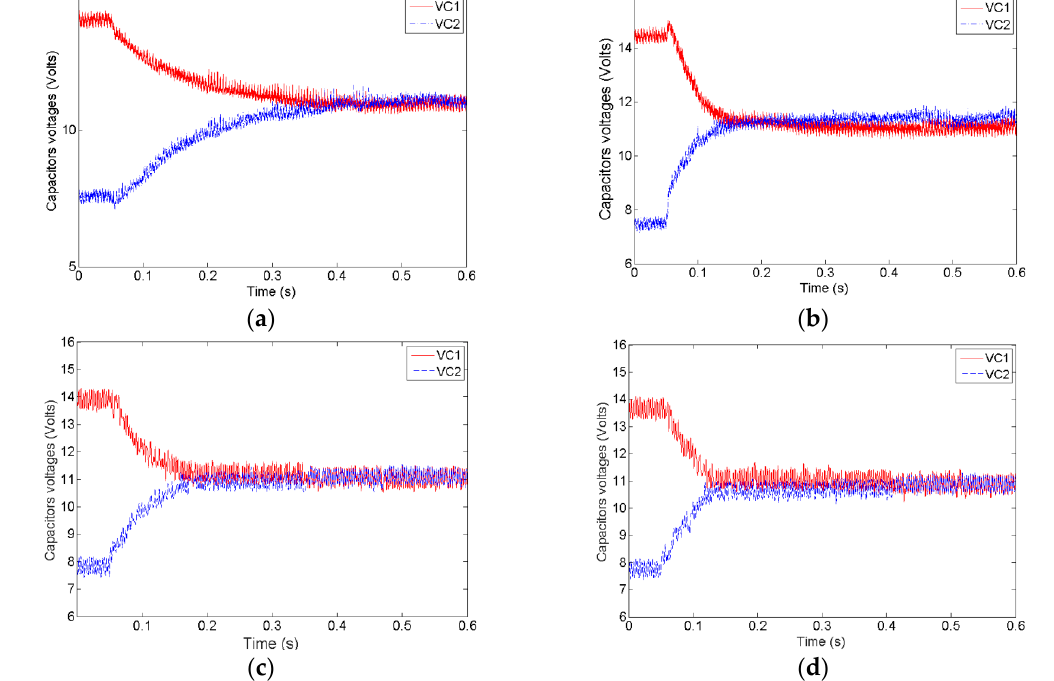
Figure 12. Experimental output capacitors ′ voltage curves: ( a ) on both switches using a PI VB controller, and ( b ) on the lower switch using a PI VB controller, ( c ) on both switches using a Fuzzy VB controller, and ( d ) on the lower switch using a Fuzzy VB controller.